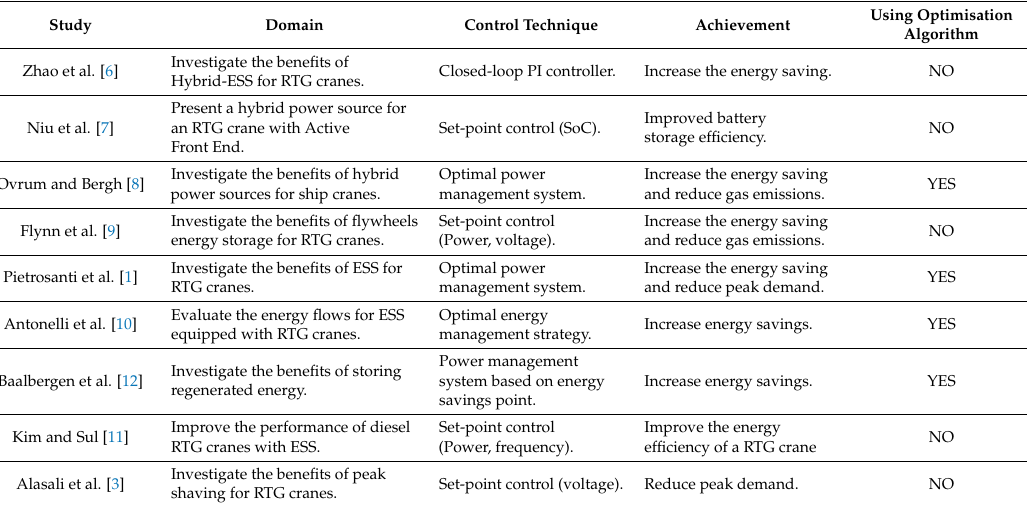
Table 1. Summary of the research for port cranes conducted by different authors along with their achievements and limitations.